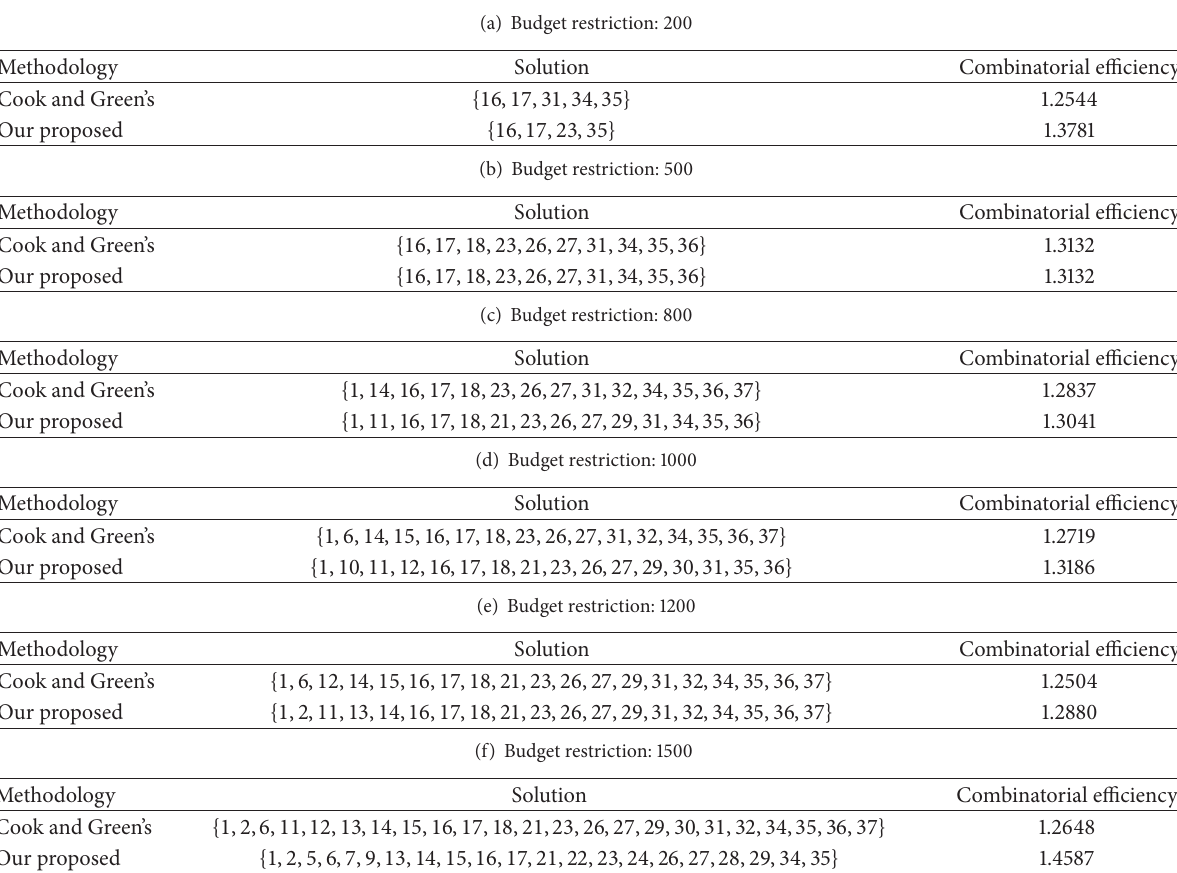
Table 8: Combinatorial efficiency evaluation with different budget